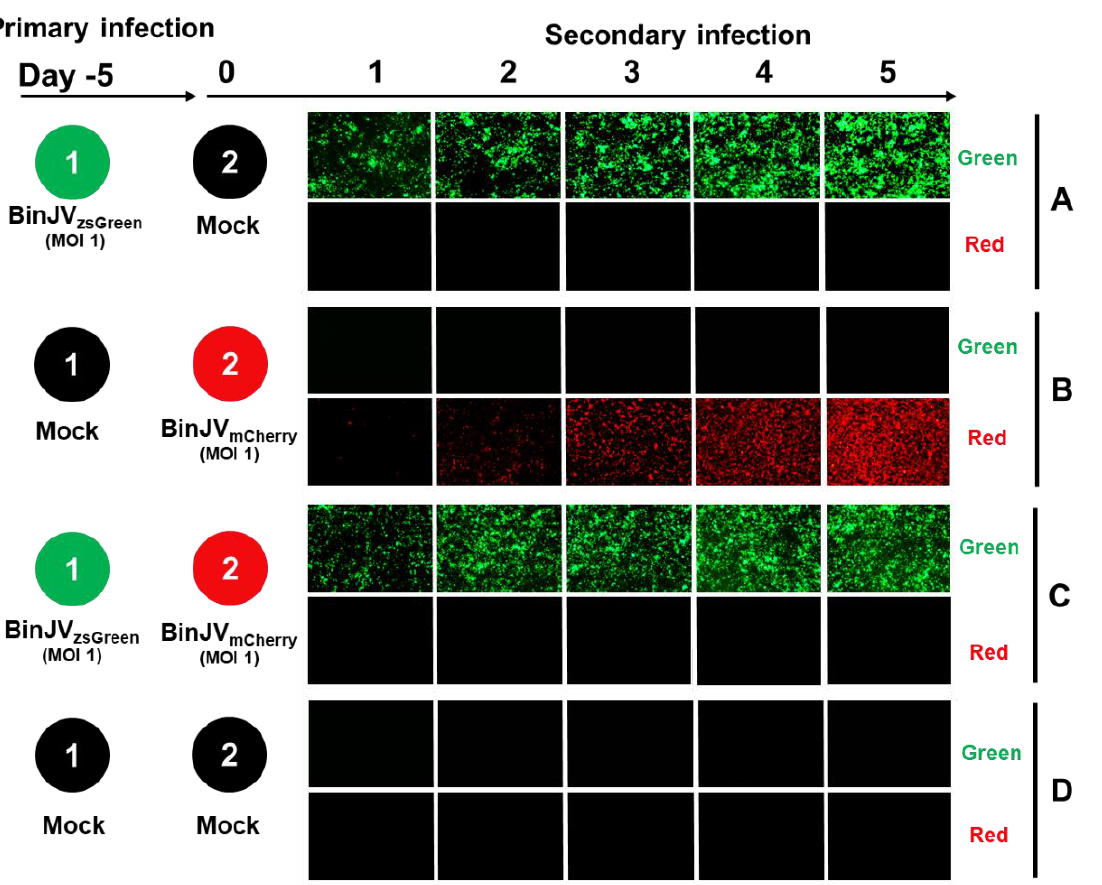
Figure 3. Superinfection exclusion between BinJV zsGreen and BinJV mCherry viruses. Schematic showing the format of the infection trials and representative images of green and red fluorescence channels of C6/36 cells with ( A ) primary infections of BinJV zsGreen at − 5 days and mock (media only) secondary infection. ( B ) Mock primary infection at − 5 days and BinJV mCherry secondary infection. ( C ) Primary infections of BinJV zsGreen at − 5 days, BinJV mCherry secondary infection, and ( D ) mock (uninfected) primary and secondary timepoints.